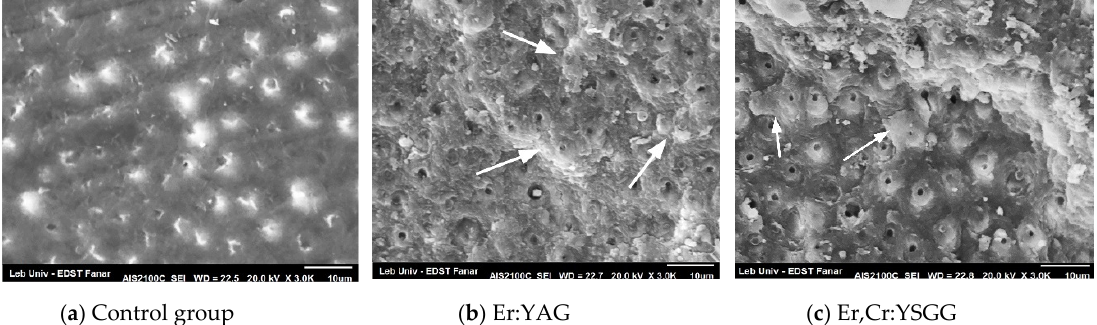
Figure 3. SEM views of thermal cycled specimens. ( a ) with very little opened tubules and absence of composite residue. ( b , c ) Few intertubular composite leftover (arrows).